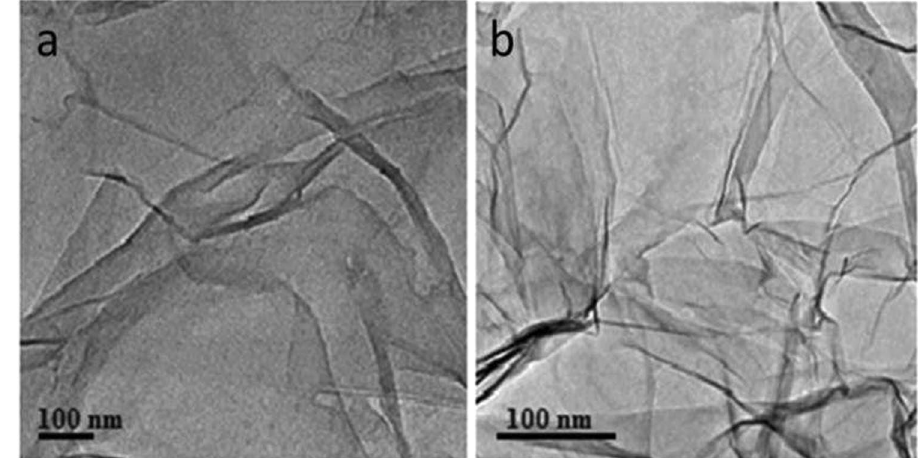
Figure 6. TEM photographs ( a ) graphite oxide ( b ) sulfonated graphene oxide.